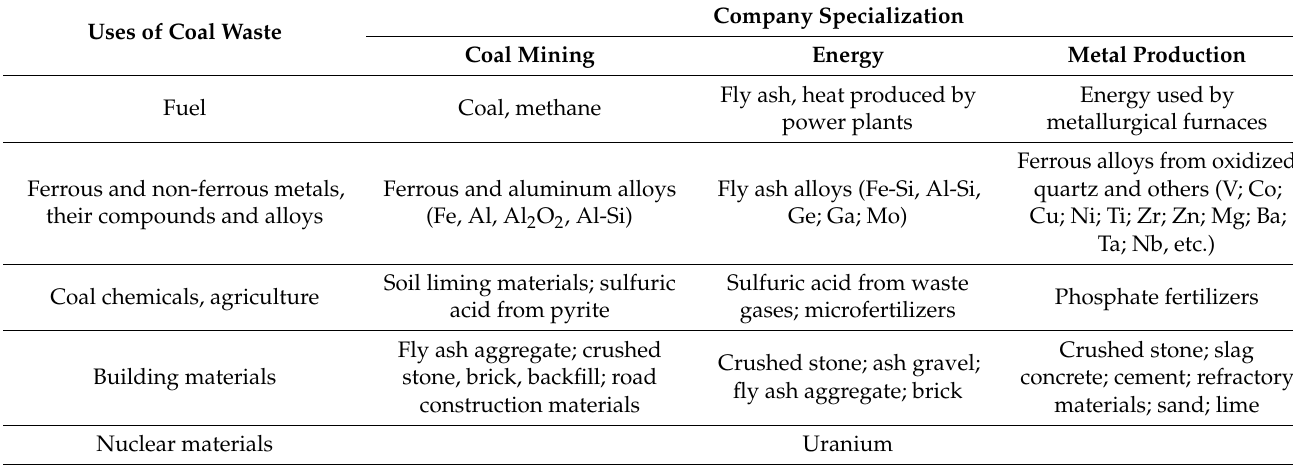
Table 2. Uses of coal waste. Source: